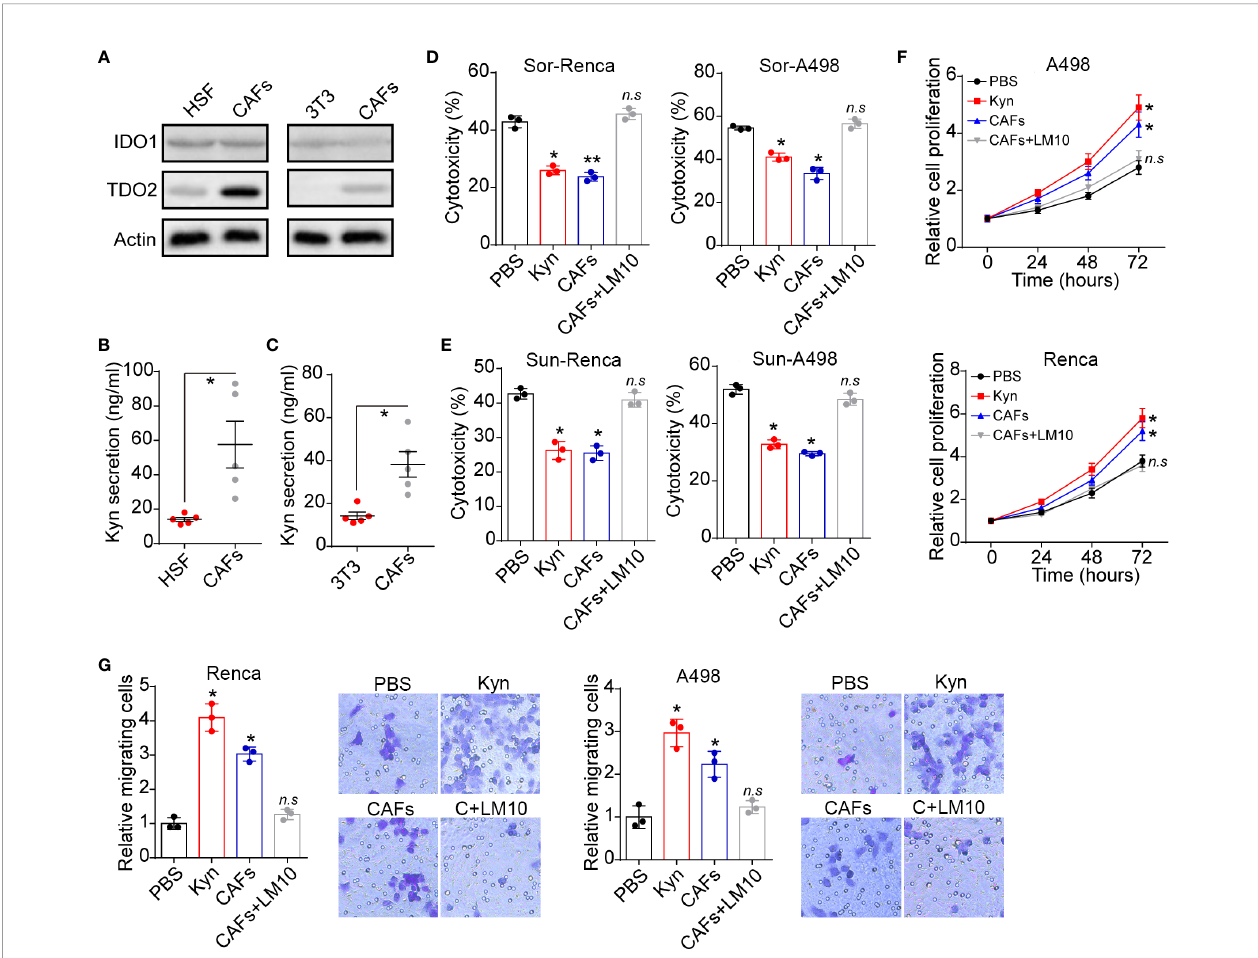
FIGURE 2 | CAFs secreted Kyn to regulate tumor progression. (A) The western blotting of IDO1, TDO2 and b -actin in HSF, NIH-3T3 and CAFs isolated from renal patients (compared to HSF) or Renca bearing mice (compared to Renca). (B) The Kyn concentration in culture medium of HSF or CAFs isolated from patients using Elisa analysis (10 5 cells in 2 ml culture medium, 48 hours). (C) The Kyn concentration in culture medium of NIH-3T3 or CAFs isolated from Renca bearing mice using Elisa analysis (10 5 cells in 2 ml culture medium, 48 hours). (D) The cytotoxicity of Sor to Renca/A498 treated with Kyn (0.5 m M), CAFs or CAFs combined with LM10 (2 m M). (E) The cytotoxicity of Sun to Renca/A498 treated with Kyn (0.5 m M), CAFs or CAFs combined with LM10 (2 m M). (F) The relative cell proliferation of Renca/ A498 treated with Kyn (0.5 m M), CAFs or CAFs combined with LM10 (2 m M). (G) The relative migrating cells numbers and representative images of Renca/A498 treated with Kyn (0.5 m M), CAFs or CAFs combined with LM10 (2 m M). Mean ± SEM, n.s, no signi fi cant difference; *p < 0.05, **p <